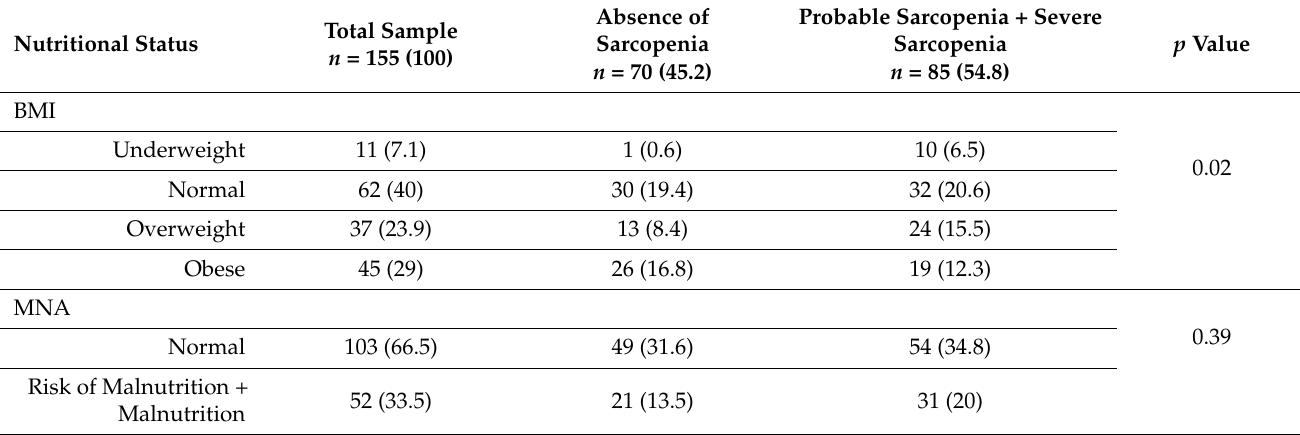
Table 5. Association between sarcopenia and nutritional status according to Body Mass Index and Mini Nutritional